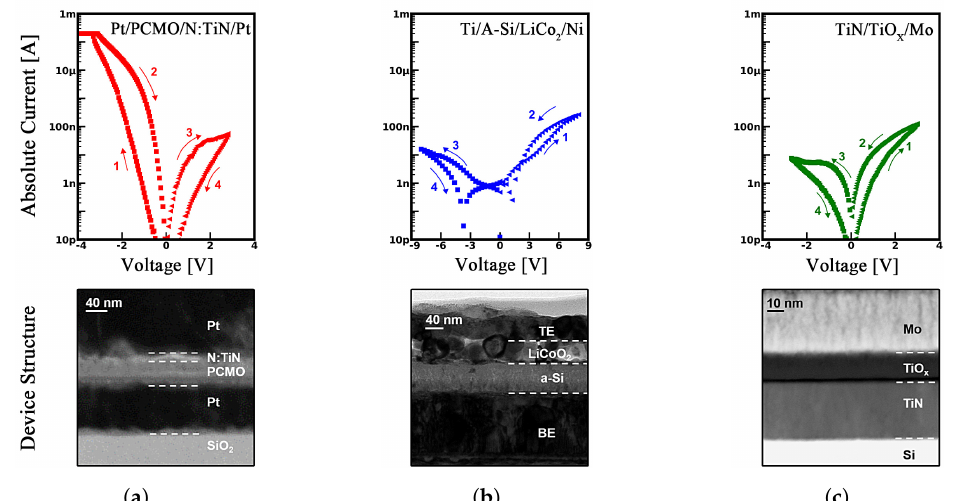
Figure 1. Cross-sectional TEM images and I–V characteristics for ( a ) PCMO synaptic devices (Pt/PCMO/N: TiN/Pt); ( b ) LiCoO 2 synaptic devices (TE/Li 1 − x CoO 2 /a-Si/BE); and ( c ) TiO x synaptic